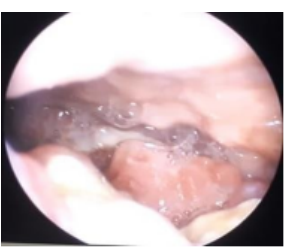
Figure 7. Proliferative mass involving left AEF, arytenoids and crico-arytenoid joint- supraglottic malignancy